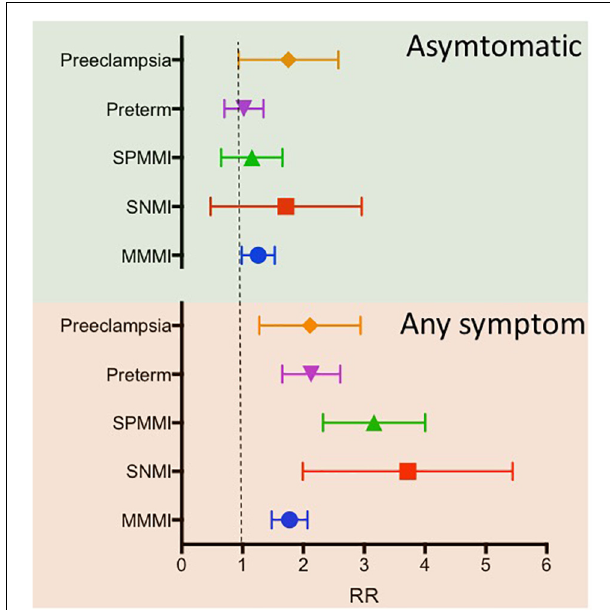
FIGURE 2 | Adjusted associations for maternal and perinatal outcomes among women with coronavirus disease 2019 (COVID-19) diagnosis according to symptom status. Adjusted models for the country, month entering study, maternal age, and history of maternal morbidity (such as diabetes, thyroid, and other endocrine disorders, cardiac disease, hypertension, chronic respiratory disease, kidney disease, malaria, or tuberculosis). The upper panel includes asymptomatic COVID-19 positive patients. At the same time, the bottom panel indicates COVID-19 patients with any symptoms. Pre-eclampsia includes a diagnosis of eclampsia and/or HELLP syndrome. HELLP, hemolysis, elevated liver enzymes, low platelet count; MMMI, maternal morbidity and mortality index; RR, relative risk; SNMI, severe neonatal morbidity index; SPMMI, severe perinatal morbidity and mortality index. Data extracted from Villar et al.